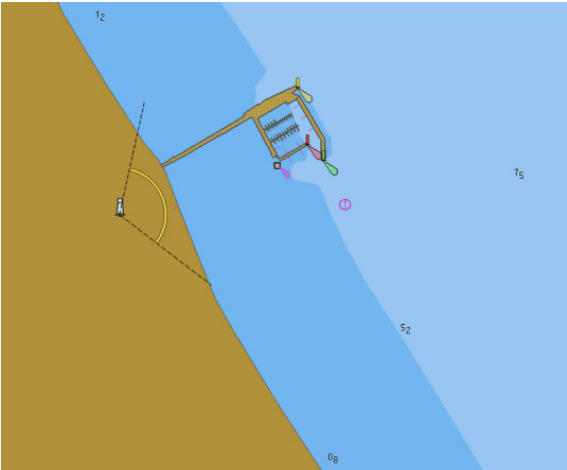
Figure 5. Bathymetric chart of the marina area in Sopot made on the basis of official electronic navigational chart (ENC) data.